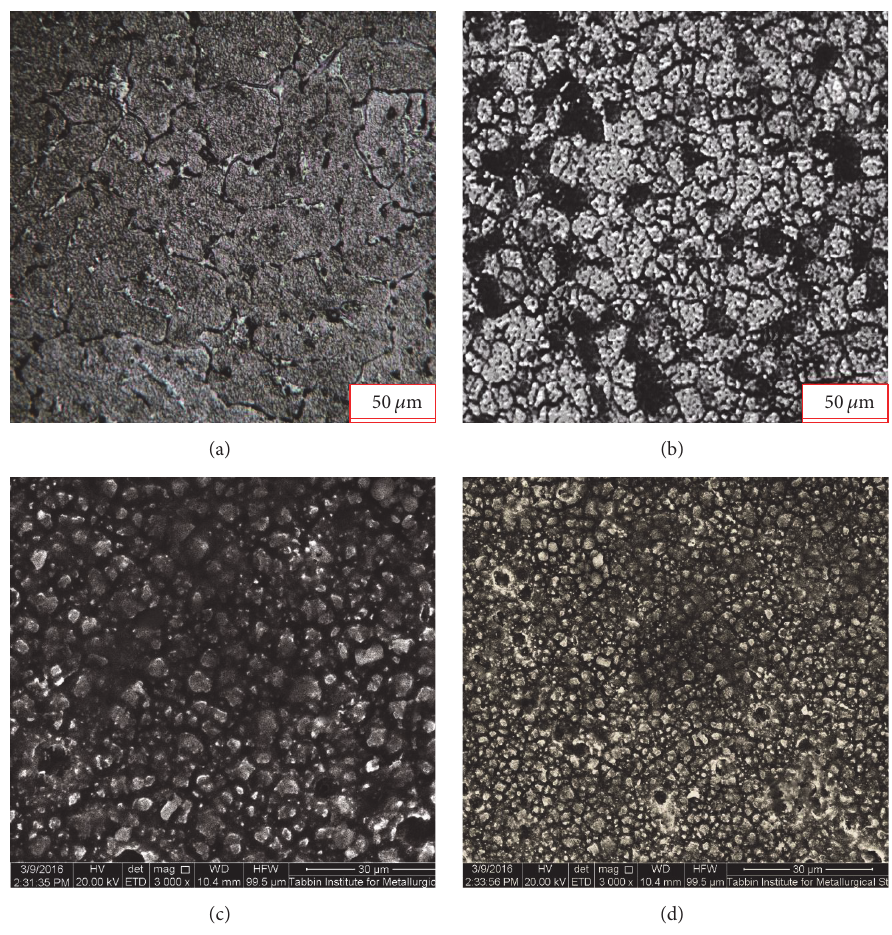
Figure 2: Microstructure of (a) as-received, (b) ET = 425 ∘ C, (c) ECAP-1, and (d) ECAP-3.